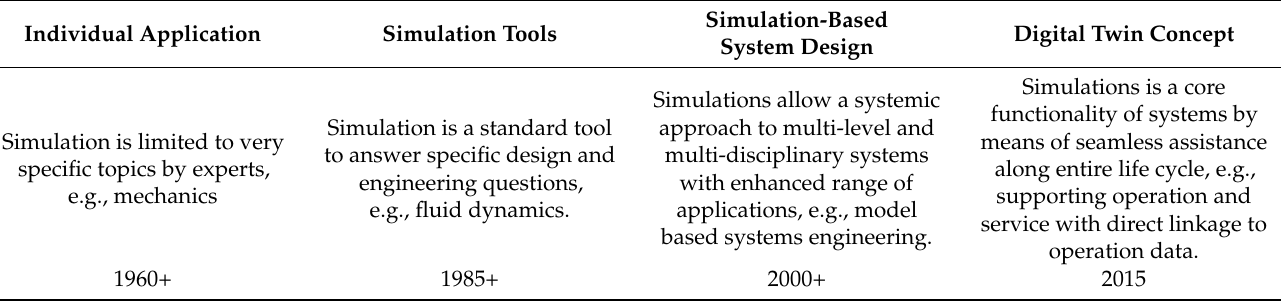
Table 3. Evolution of the simulation modeling paradigm [121].